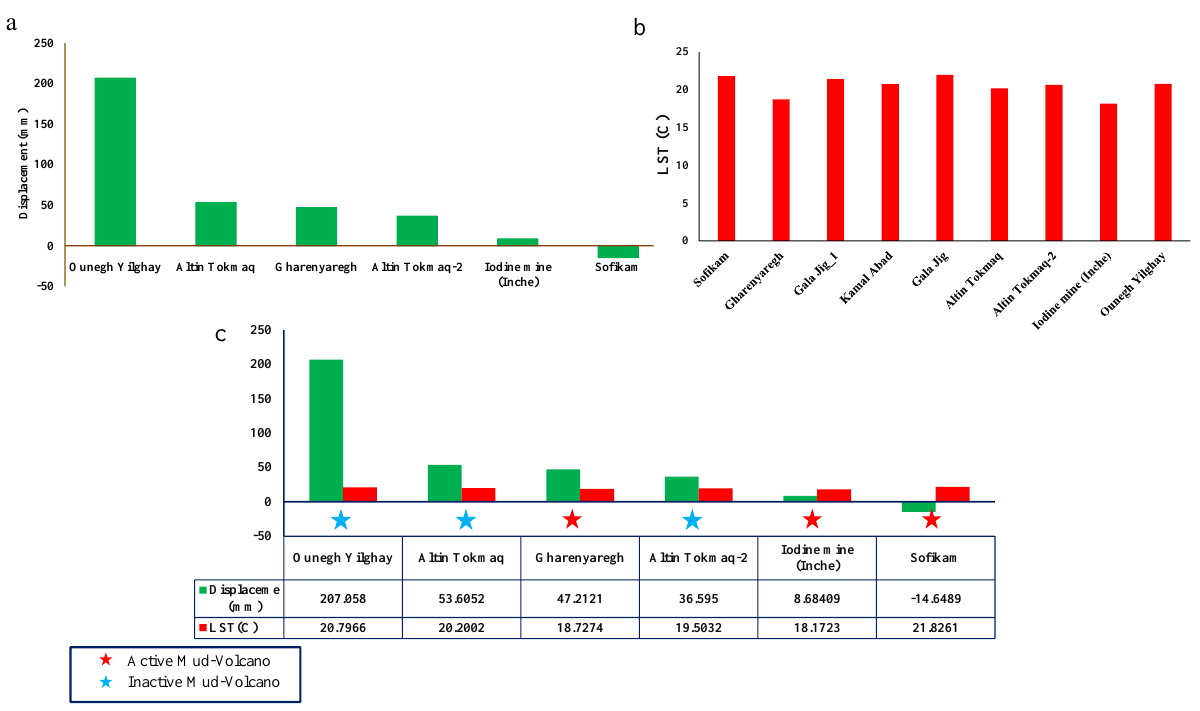
Figure 5. displacement map (mm) (a); LST map (b); Comparison of surface displacement and LST mud volcanoes